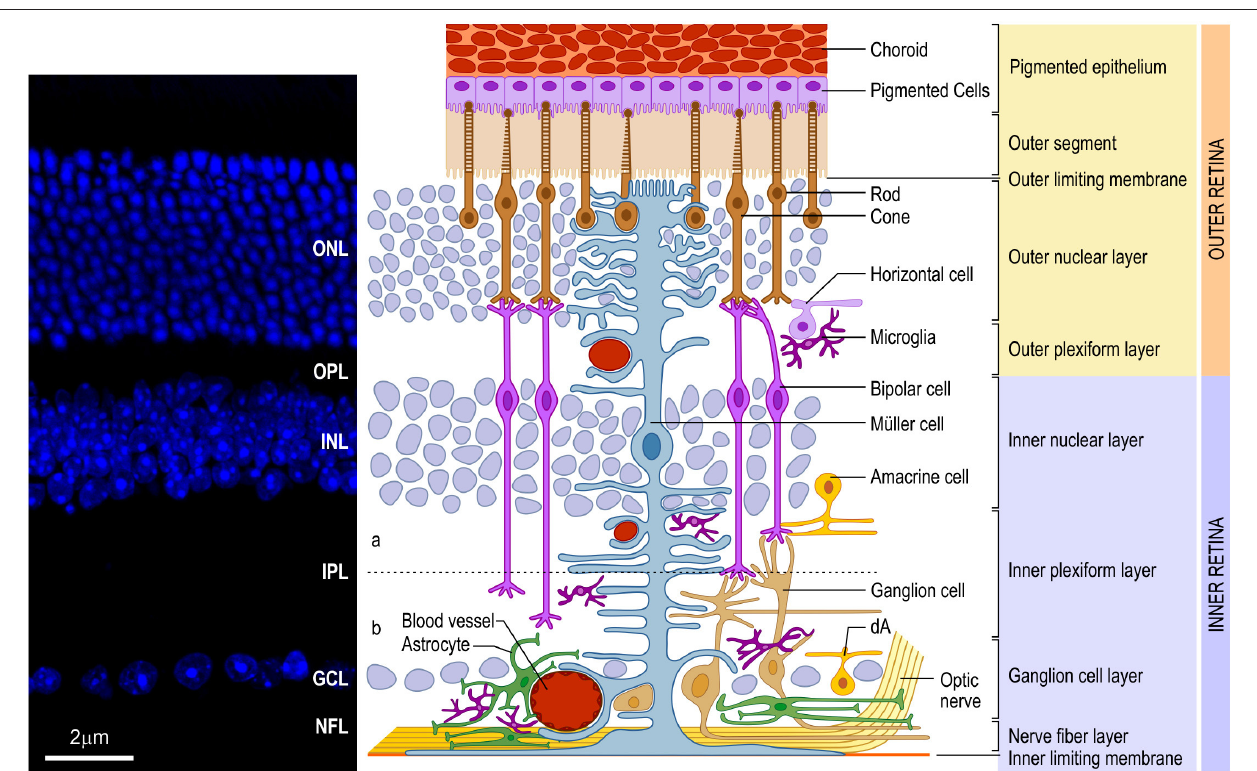
FIGURE 1 | Schematic organization of the vertebrate retina. (Left) Vertical section of mouse retina labeled with nuclear marker DAPI revealing the organization of the retina in layers of cell bodies and process named as follows: ganglion cell layer (GCL), inner plexiform layer (IPL), inner nuclear layer (INL), outer plexiform layer (OPL), outer nuclear layer (ONL), and inner/outer segment of photoreceptors (IS/OS). (Right) The retina consists of different cell types located in specific layers. Cell bodies of rod and cone photoreceptors (brown) are located in the ONL. Both photoreceptors perform synapses in the OPL with bipolar (purple) and horizontal (lilac) cells, which, in turn, show the cell bodies in the outer portion of INL, as well as amacrine (yellow) cells and Müller (blue) cells. Bipolar and amacrine cells arborize in the IPL, contacting ganglion cell dendrites. Rod bipolar cells arborizes in the inner portion of IPL. Cone bipolar cells (right pair of purple cells) are subdivided in ON and OFF bipolar cell contacting the same cone in the OPL and synapsing, respectively, in the ON (b) or OFF portion of the IPL [dashed line shows the functional division of the IPL in OFF (a) and ON (b) circuitries. Ganglion (orange), as well as displaced amacrine (dA) cell bodies are situated in the GCL. Axons of ganglion cells form the nerve fiber layer (NFL), leave the retina through the optic head nerve taking the information to visual brain nuclei by optic nerve (ON). The three types of glial cells (Müller, astrocytes, and microglia) are found in different retinal layers. Astrocytes (green) are restricted to the inner portion of the retina, in the NFL and GCL, and have a close relation to blood vessels. Microglia (dark purple) appear preferentially in the plexiform layers (IPL and OPL). Finally, Müller cells, the predominant glia in the retina, extend their processes radially throughout the retina forming the inner limiting membrane (ILM) and the outer limiting membrane (OLM). Muller glia processes interacts with almost all retinal cell types, including blood vessels, displaying a crucial role in the physiology of this tissue. In mice and humans, the inner retina is vascularized by three capillary branches of central retinal artery. The outer retina, with the avascular photoreceptor region, relies on the choriocapillaris (Ch) lying beneath the retinal pigment epithelium (RPE)]. Scale bar: 20 µ